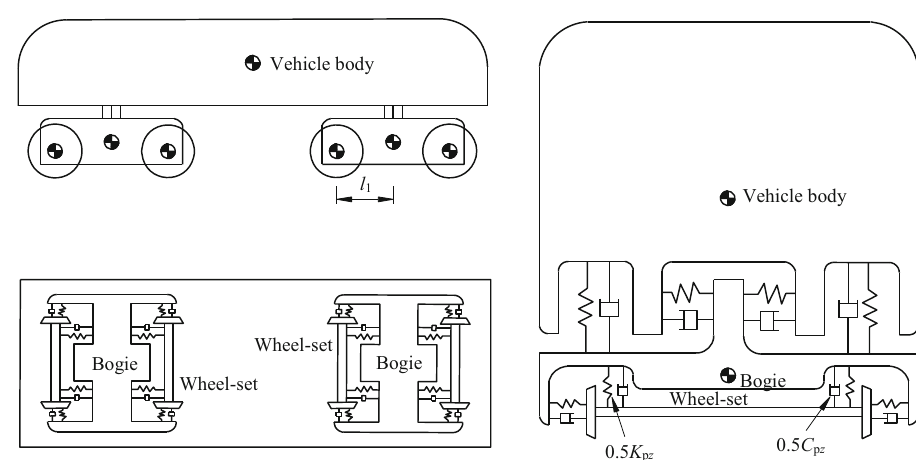
Fig. 1 Mass-spring-damping model of the